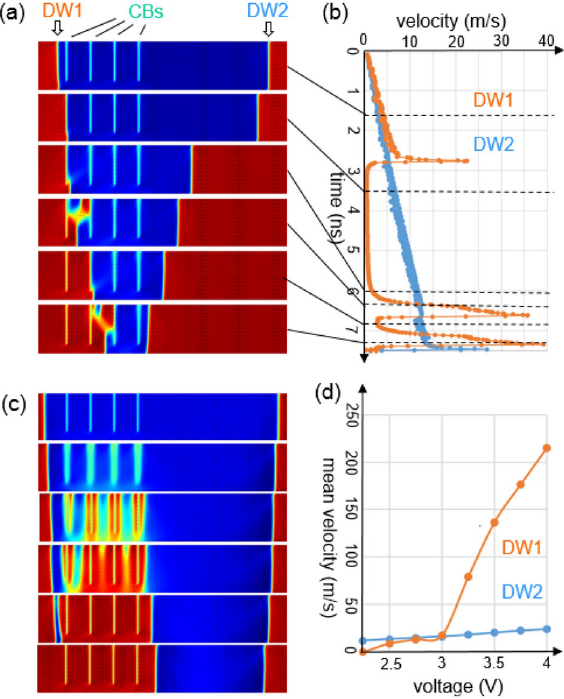
Figure 3. 180-degree domain walls and their interaction with columnar boundaries. ( a ), ( b ) Ferroelectric switching with voltage linearly with time from 0 to 3 V. ( a ), ( d ) Switching at constant voltage, ( c ) 4 V, ( d ) DW mean speed on voltage dependence. Film thickness 20